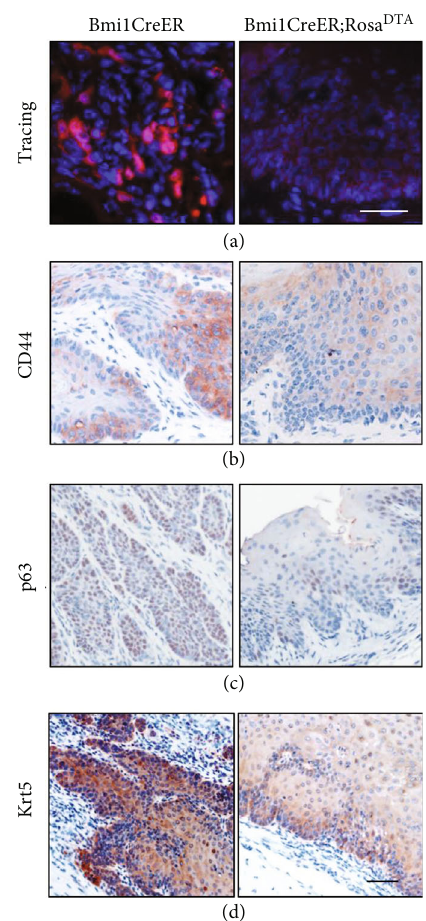
Figure 4: The stemness phenotype of ESCC without Bmi1 + cells was inhibited. (a) Samples of control and Bmi1CreER; Rosa tdTomato ;Rosa DTA mice were collected on the 21st day after a single intraperitoneal injection of tamoxifen. Bmi1 + cells of Bmi1CreER;Rosa tdTomato ;Rosa DTA mice were e ff ectively removed. Red labels Bmi1 + cells and their progenies. (b – d) In ESCC samples, all three types of TIC markers, CD44 (b), tp63 (c), and Krt5 (d), were reduced after Bmi1 + cells were removed. Brown represents the signals of interest. Scale bars are 100 μ